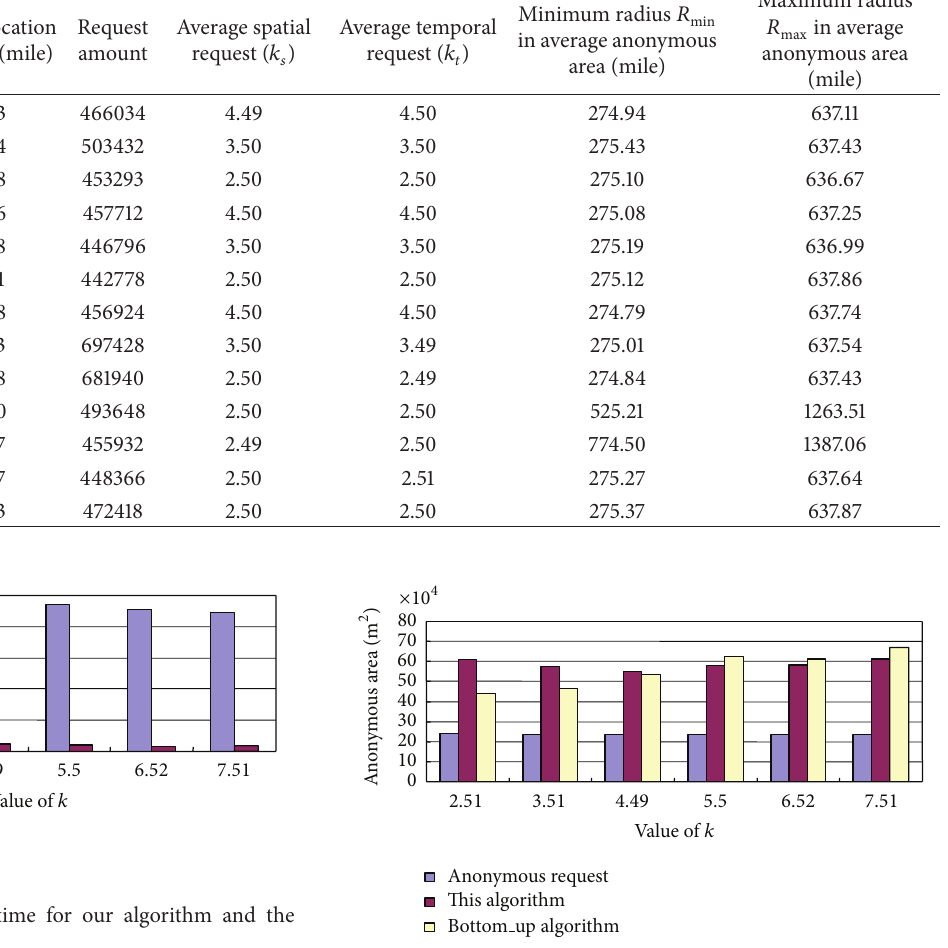
Figure 5: Anonymous area of our algorithm and the Bottom up